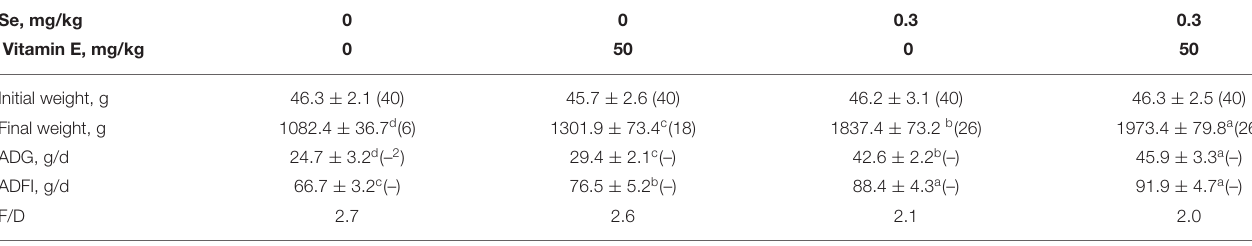
TABLE 2 | Effects of dietary Se and vitamin E (VE) on growth performance in chicks 1 . Se, mg/kg